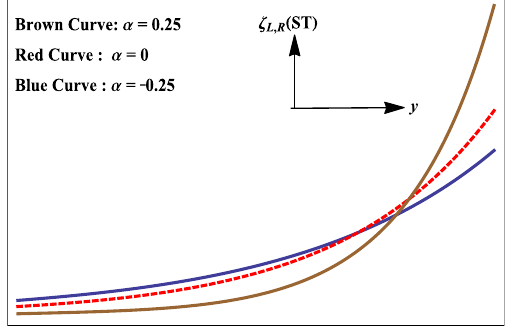
Fig. 6 ˜ ζ L , R ( = ζ L , R ( ST ) in the diagram) vs. y for M = 1, (cid:9) = − 1 and m 5 = 0